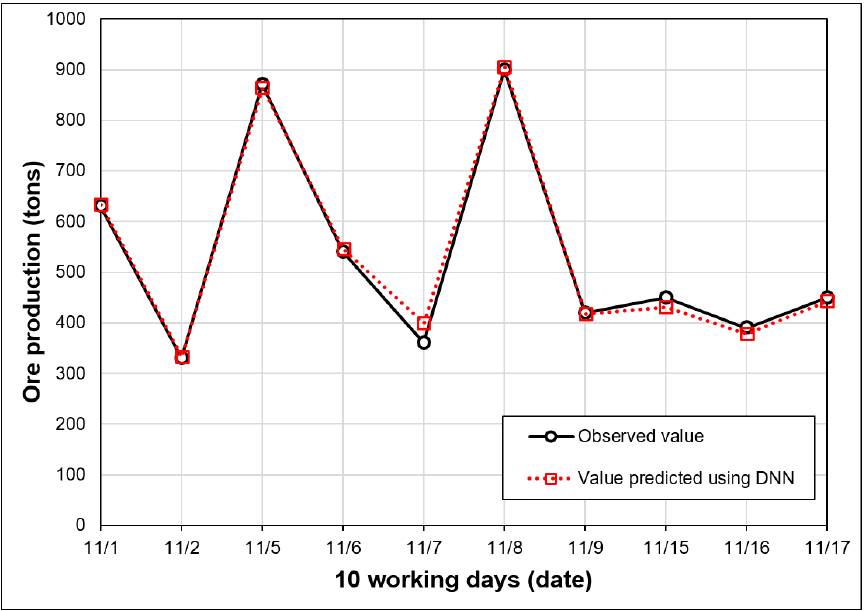
Figure 10. Comparison of measured ore production and value predicted using optimal DNN model.